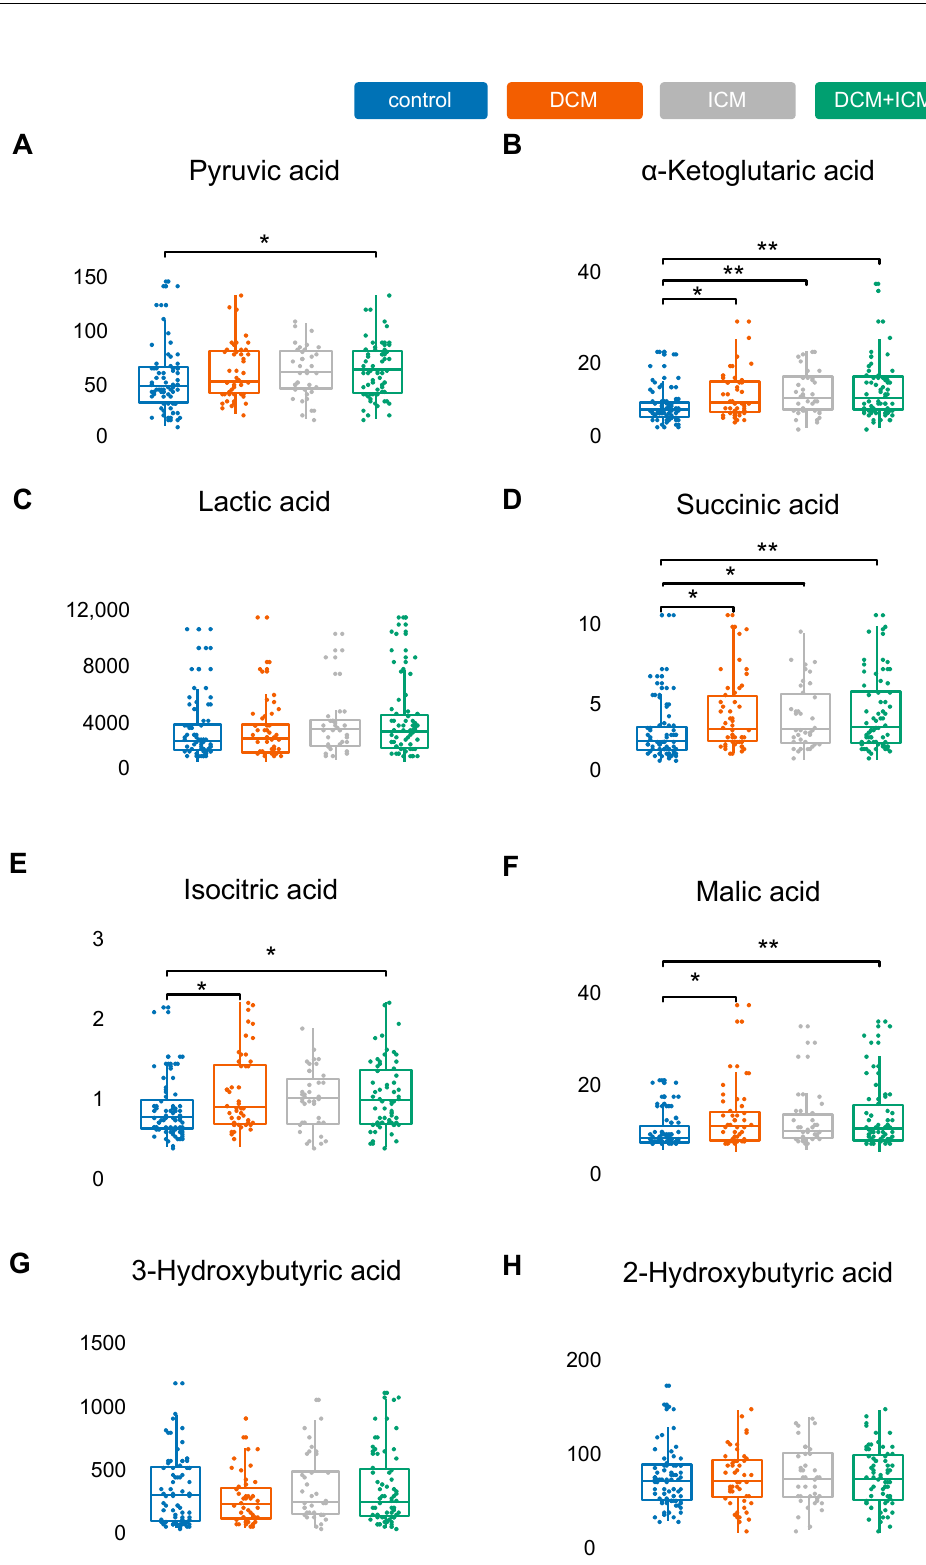
Figure 5. Validation in independent HF cohorts. While changes in pyruvic acid levels could not been replicated ( A ), the HF-related upregulation of α -Ketoglutaric acid ( B ) was validated, while lactic acid ( C ) levels are not significantly altered in this cohort, in contrast to succinic acid ( D ), which was successfully validated. Isocitric and malic acid were also increased ( E , F ). Levels for 2-Hydroxybutyric and 2-Hydroxybutyric acid were found to be unaltered ( G , H ). Control (CTRL) samples are depicted in blue. Values for samples from the Dilated Cardiomyopathy (DCM) cohort are colored orange. Ischemic cardiomyopathy subgroup (ICM) is painted grey. Values for the combined cohort of DCM and ICM samples (DCM/ICM) are shown in green. Significance values are given. Metabolite concentrations are shown as [ µ M]. *: p < 0.05; **: p <